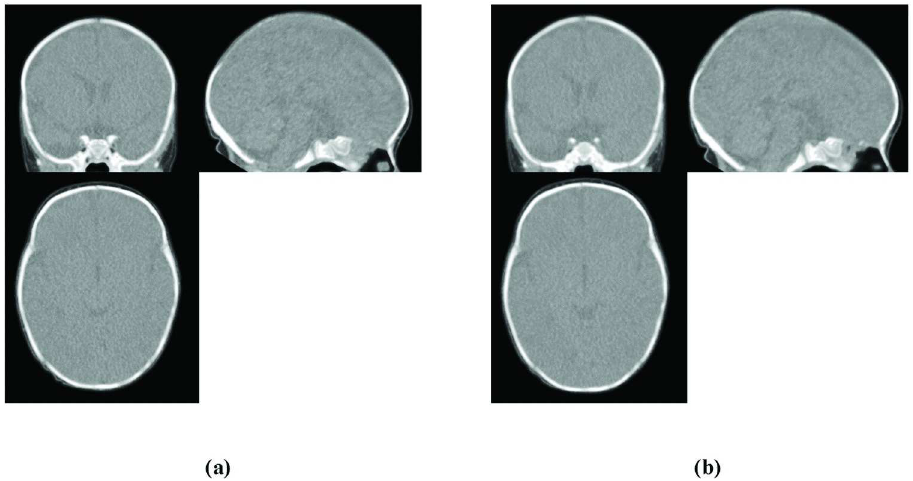
Fig 6. CT’-MR co-registration, second step: whole head intensity-based registration. (a) CT’ image obtained by applyingthe resultingdeformation field from CT-MR intracranialco-registration sub-sectionto the preprocessed CT image. (b) CT’’ image achievedby linearlyregisteringCT’ to GRAMFC_T 39-42